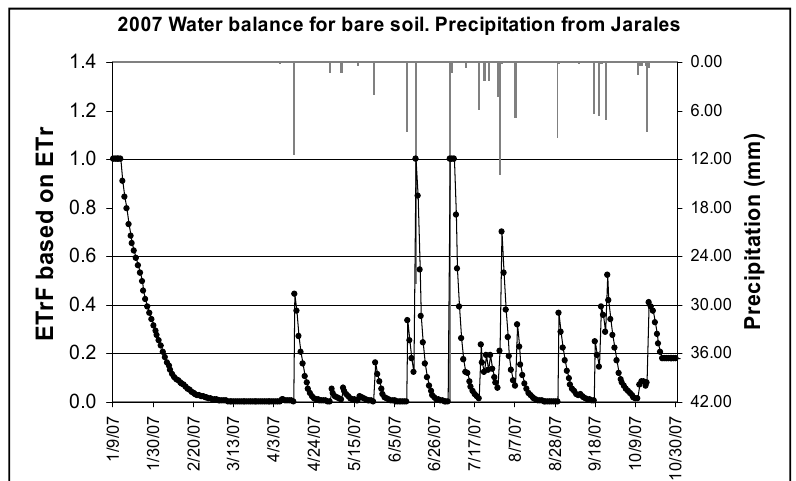
Figure 6. Evaporation estimated using a daily soil water balance for a bare soil condition based on reference ET and precipitation data from Jarales, 2007. Daily precipitation is shown on the right y-axis and is plotted from the top of the